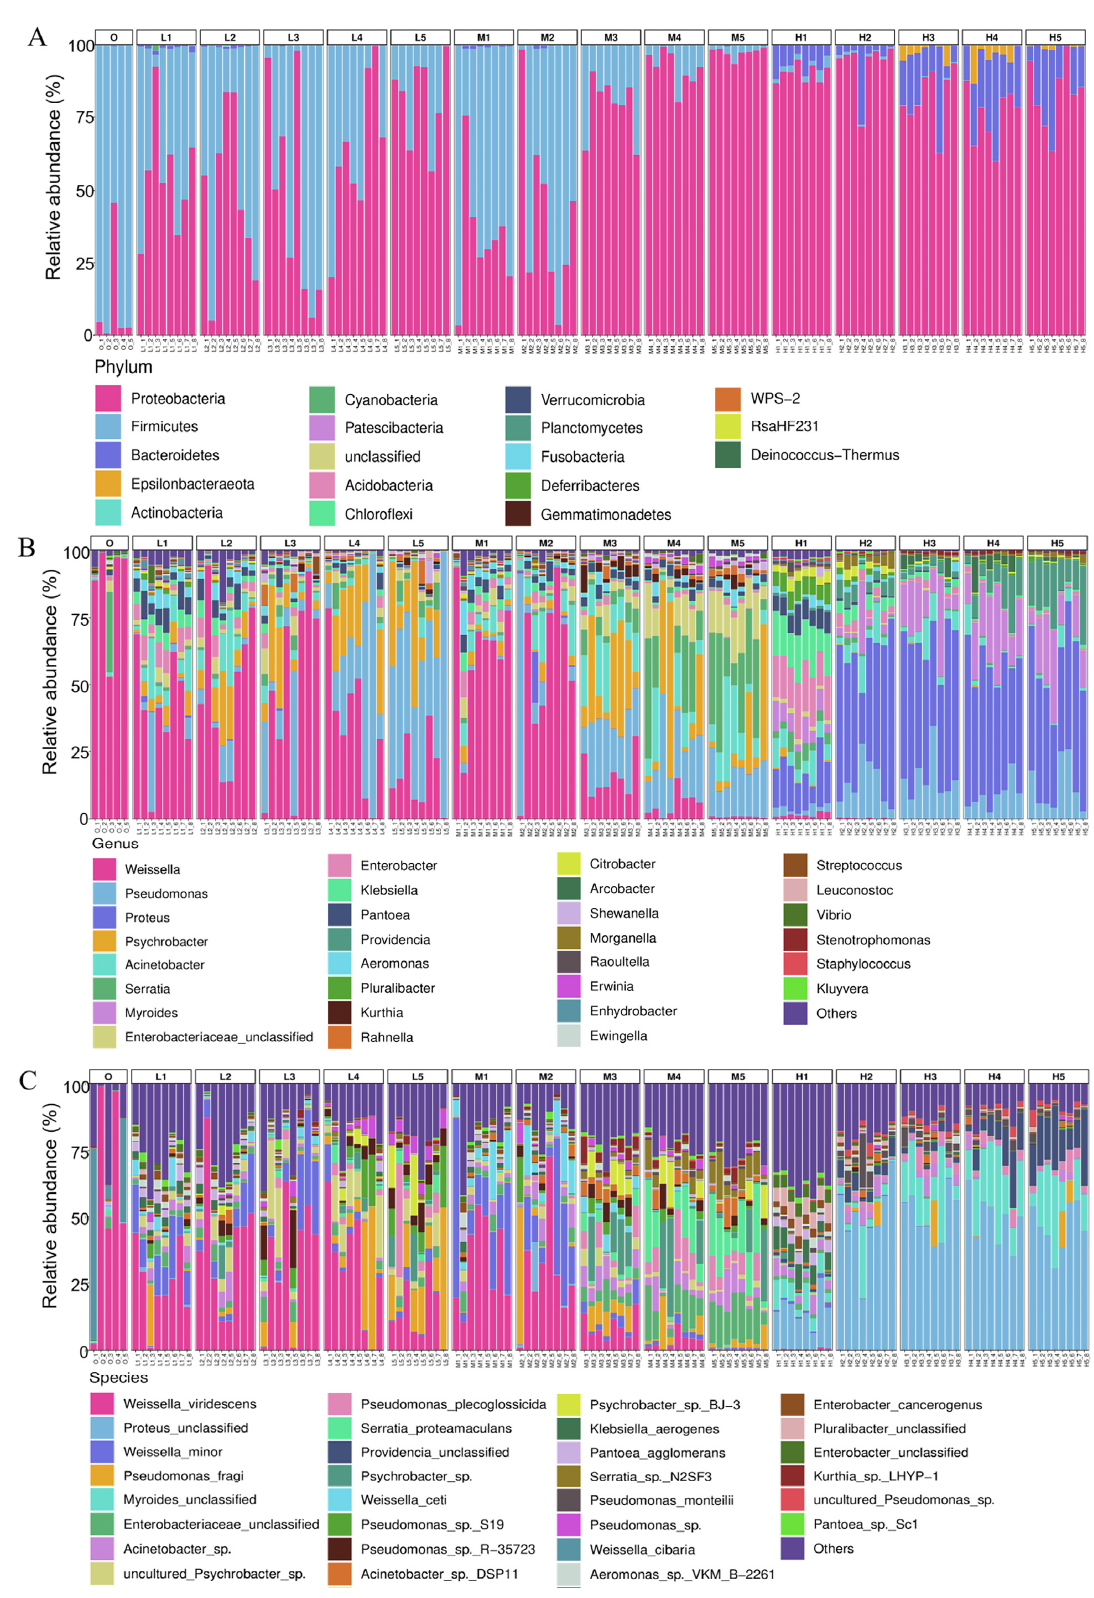
Figure 2. Relative abundance (%) of bacterial taxa based on 16S rDNA sequencing. ( A ) Phylum, ( B ) genus and ( C ) species levels in the RTE chicken meat samples during storage. The multi-colored stack bar graphs display the relative abundances of bacteria in each